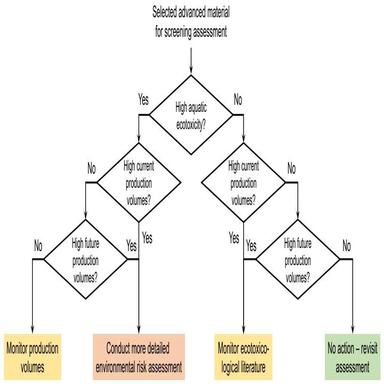
Recommended actions depending on the outcome of the proxy measure risk screening approach.